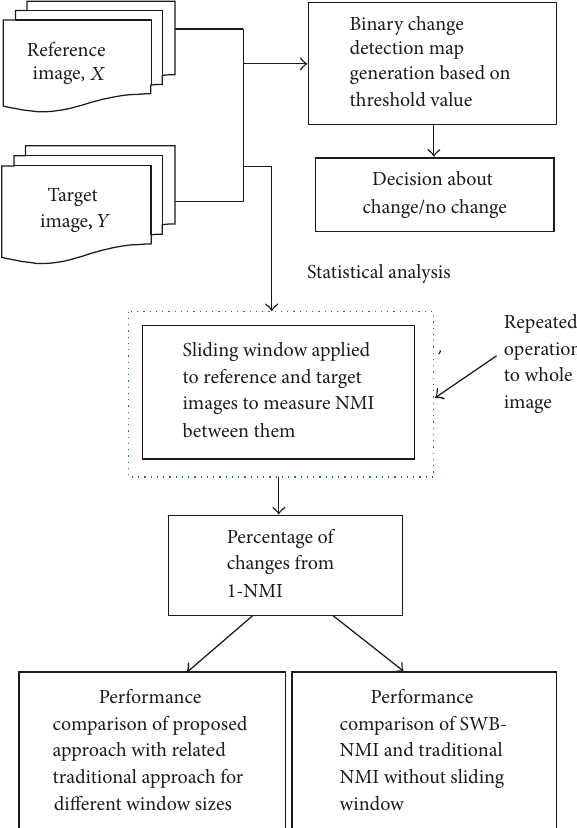
Figure 2: Methodology of proposed change detection